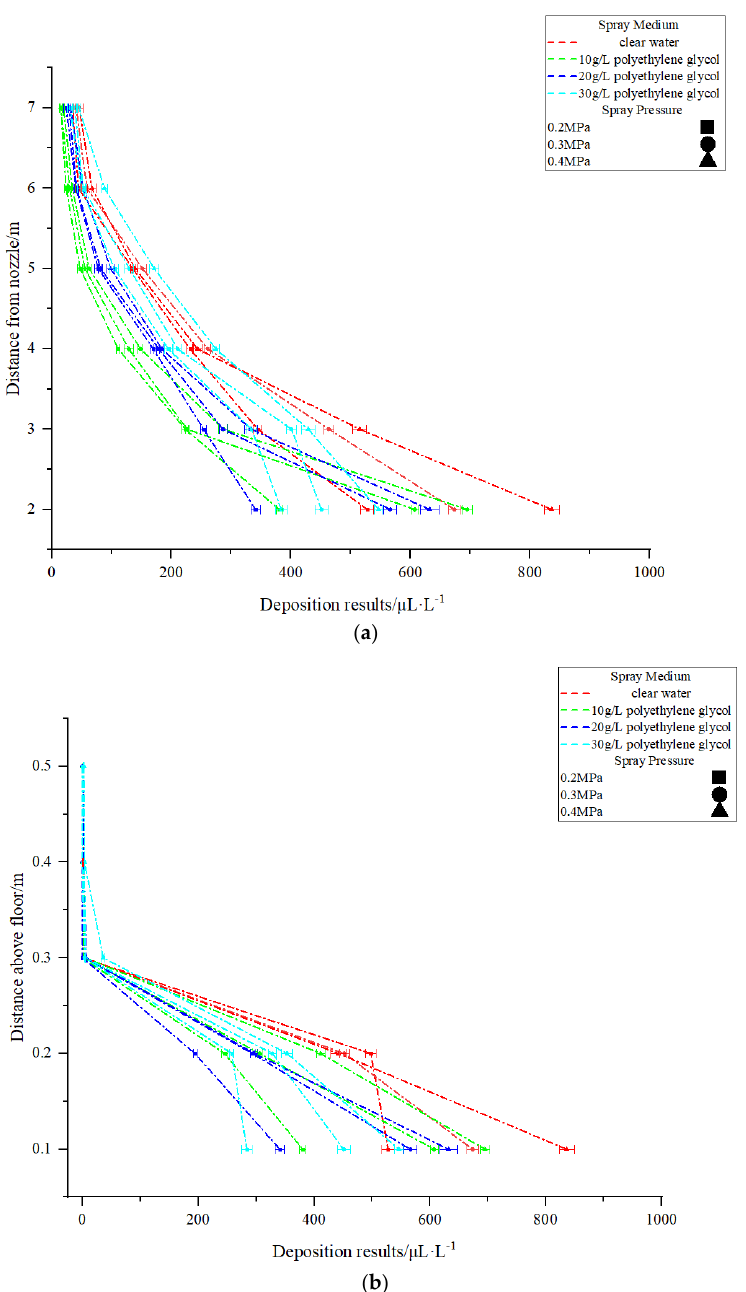
Figure 5. Deposition distribution under different spray conditions. ( a ) Distribution of deposition in the horizontal direction under different spray conditions. ( b ) Distribution of vertical deposition under different spray conditions.